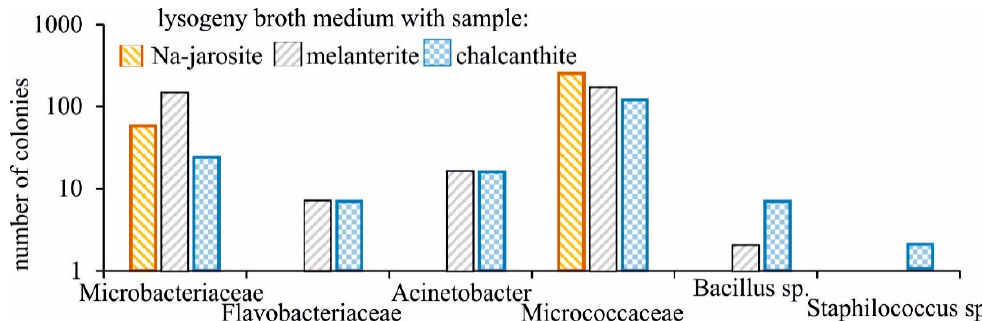
Figure 3. Taxonomic diversity of the growing bacteria strains on medium with the studied samples.